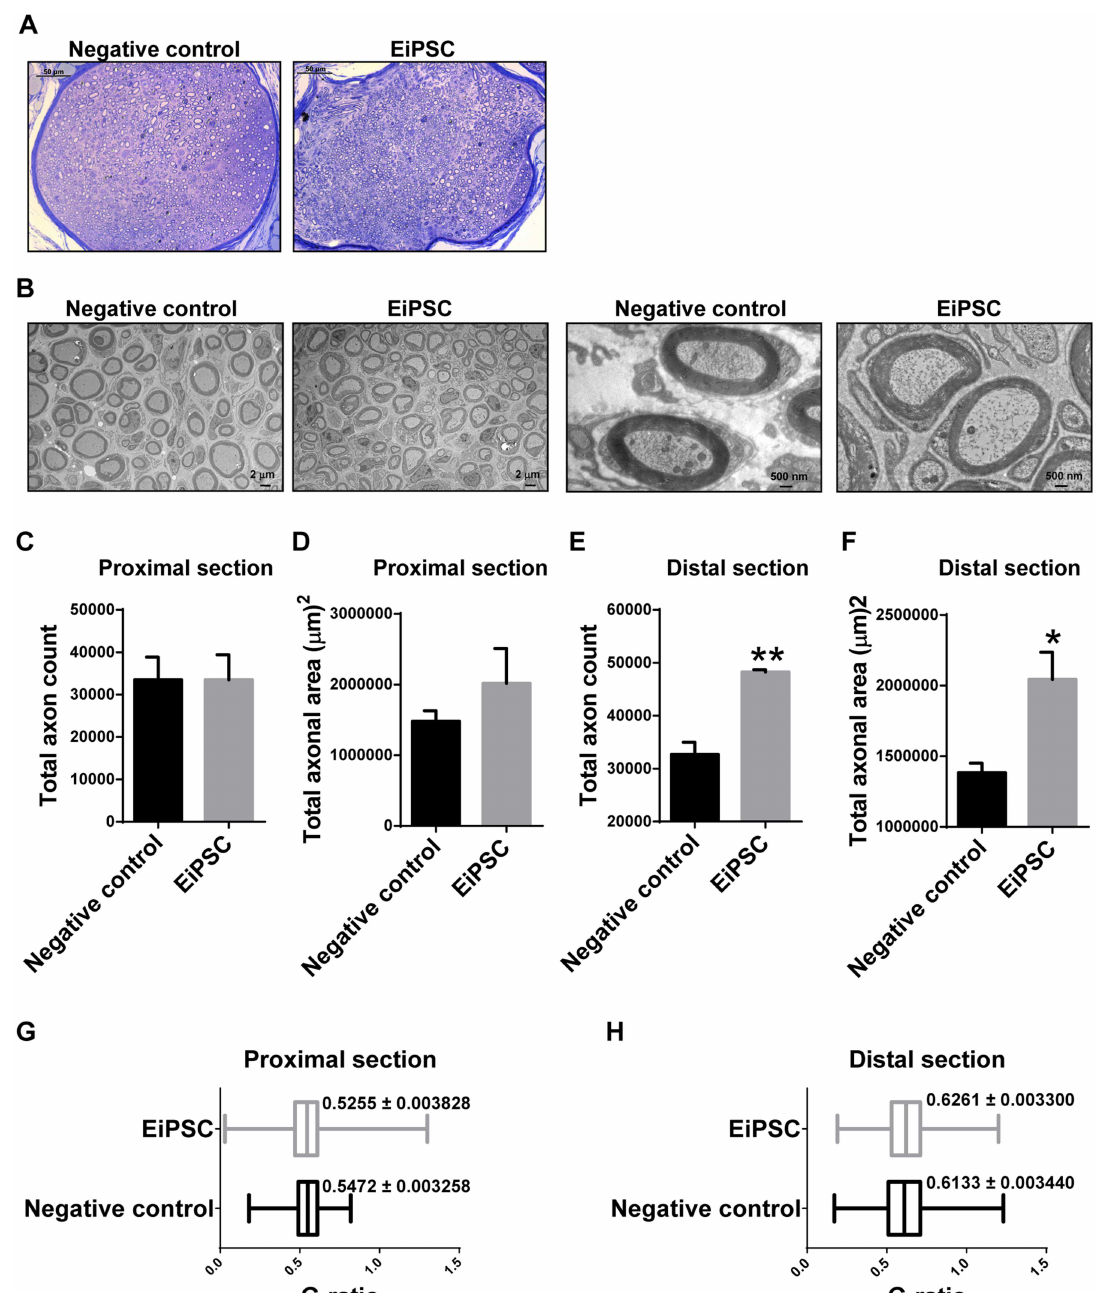
Fig 5. Stereographic analysis of sciatic nerve regeneration. (A) Toluidineblue staining of fascicles in the distal section of regenerated sciatic nerves. Each scale bar represents 50 μ m. (B) Electron microscopy of regenerated axons in both negative control and EiPSC groups at the distal sections. The scale bars for two images on the left are 2 μ m each and 500 nm for two images on the right. (C, E) Total axon count in the proximal (C) and distal (E) section of regenerated sciatic nerves. (D, F) Total axonal area in the proximal (D) and distal (F) section of regenerated sciatic nerves. (G-H) G-ratio comparingthe proximal (G) and distal (H) section of regenerated sciatic nerves in both EiPSC and negative control groups.